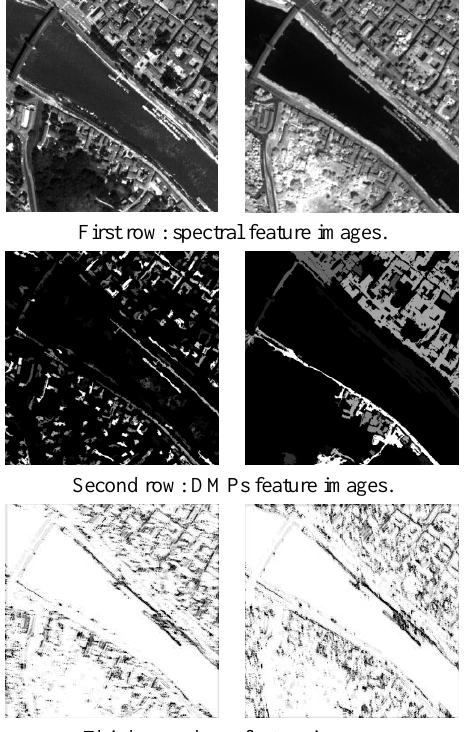
Second row: DMPs feature images.